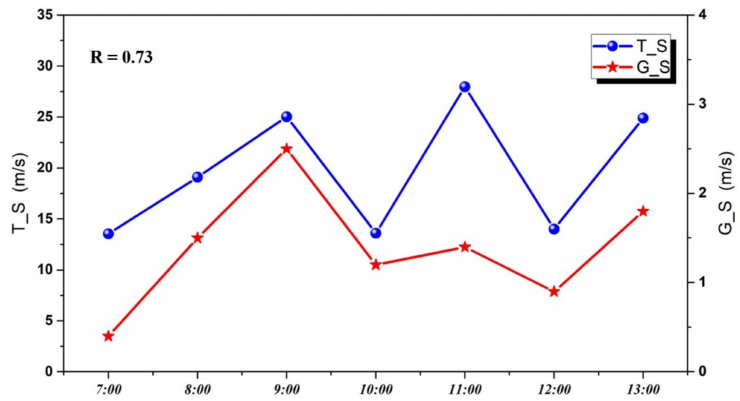
Figure 7. Speed of pollutant transmission and near-surface wind. G_S and T_S represent near-surface wind speed obtained from ground-monitoring and speed of pollutant transmission, respectively.